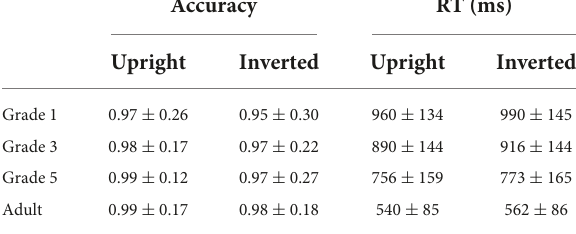
monitor (CRT; 1,024 × 768 pixel resolution) on which stimuli were presented on a dark gray background. E-Prime 2.0 software (Psychology Software Tools, Pittsburgh, PA, United States) was used to present the stimuli and collect the behavioral responses.